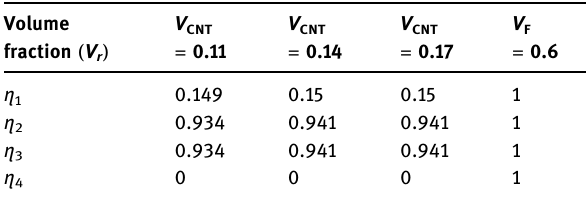
Table 2: Values of the e ffi ciency parameters η Volume